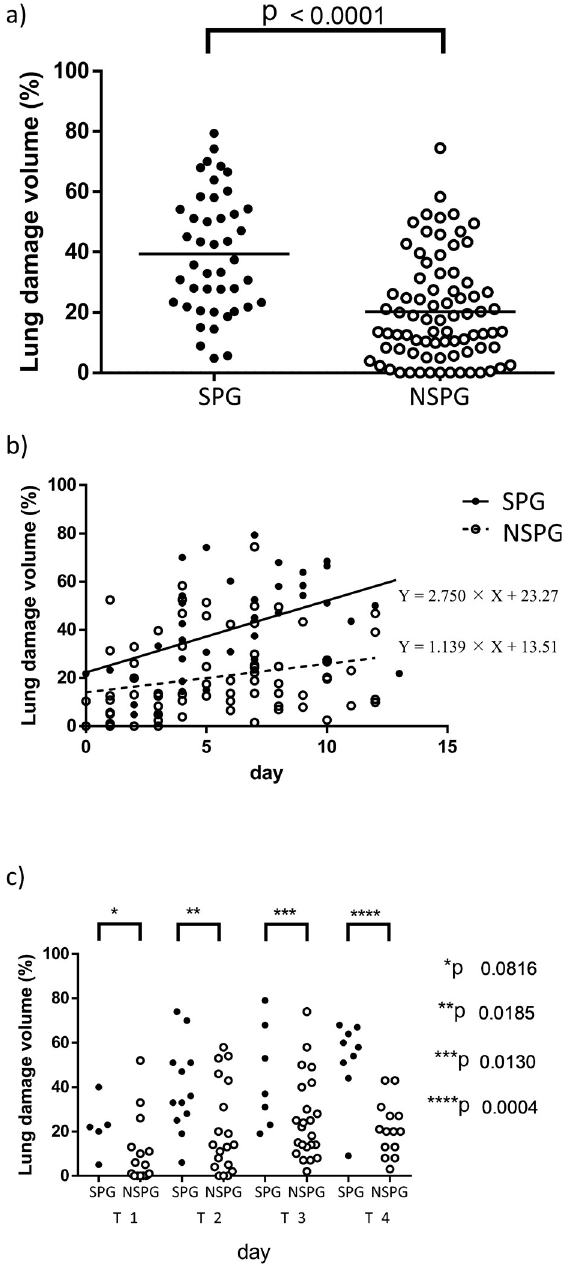
Fig 5. Comparison of the extent of lung damage in individuals aged � 65 years. a) Comparison of the extent of lung damage. b) Time since onset and extent of lung damage in the SPG and NSPG. c) Comparison according to